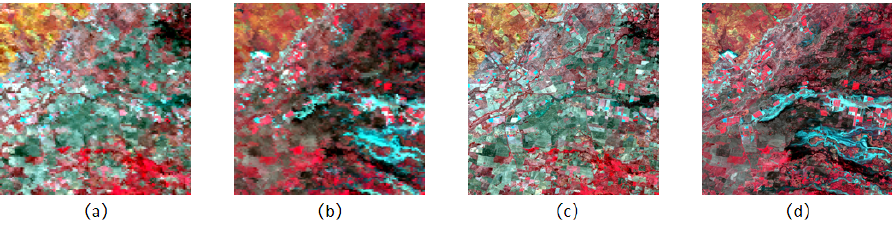
Figure 9. Test data from the LGC dataset. These figures exhibit the false color composite images using band 4, band 3, and band 2. ( a , c ) are the MOIDS and Landsat images on 26 November 2004, respectively. ( b , d ) are the MOIDS and Landsat images on 12 December 2004, respectively.